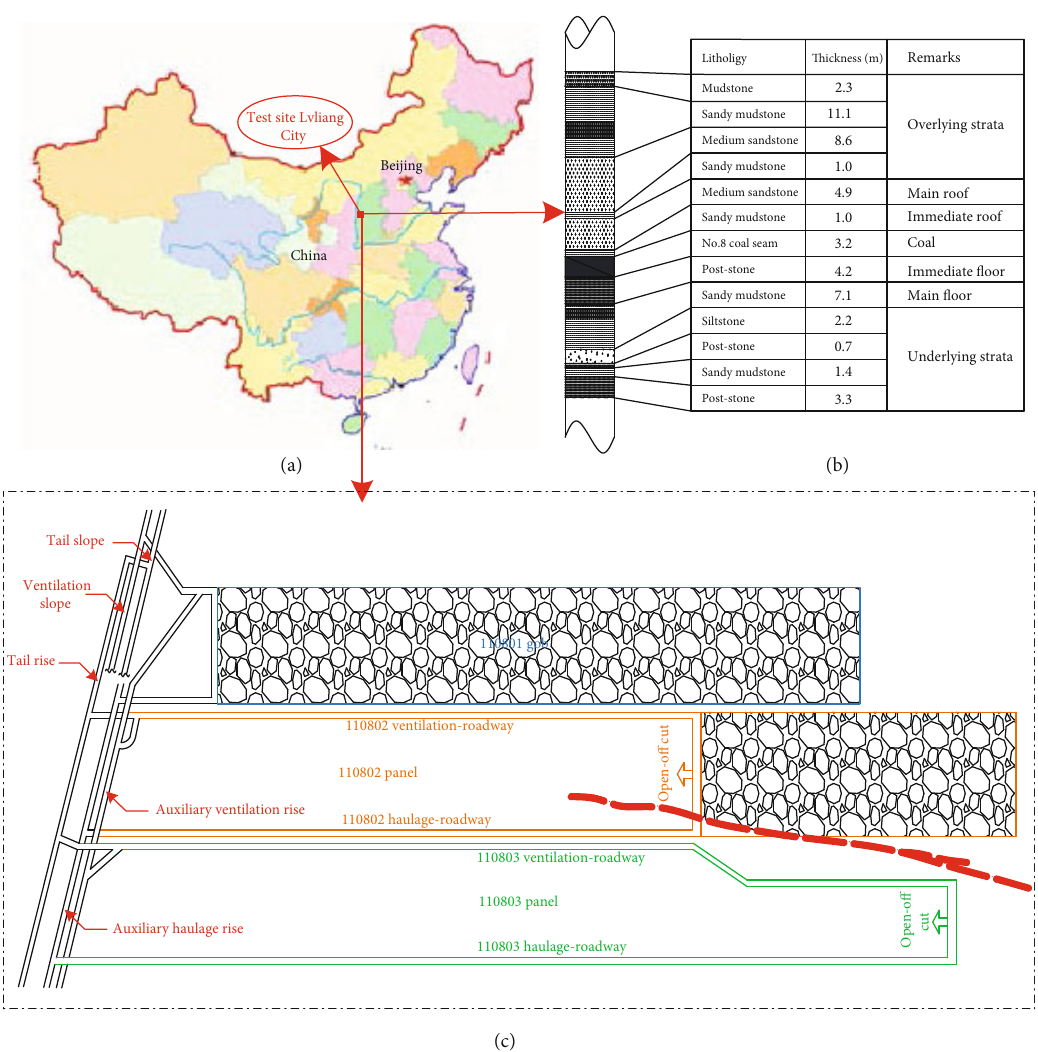
Figure 9: Mine location and panel layout of the test site: (a) location of the test site, (b) generalized stratigraphic column of the test site, and (c) the layout of the